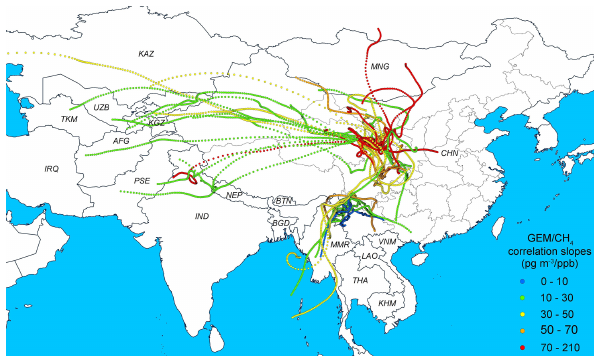
Figure 6. Correlation slopes of GEM/CH 4 at WLG and XGL and associated origins of